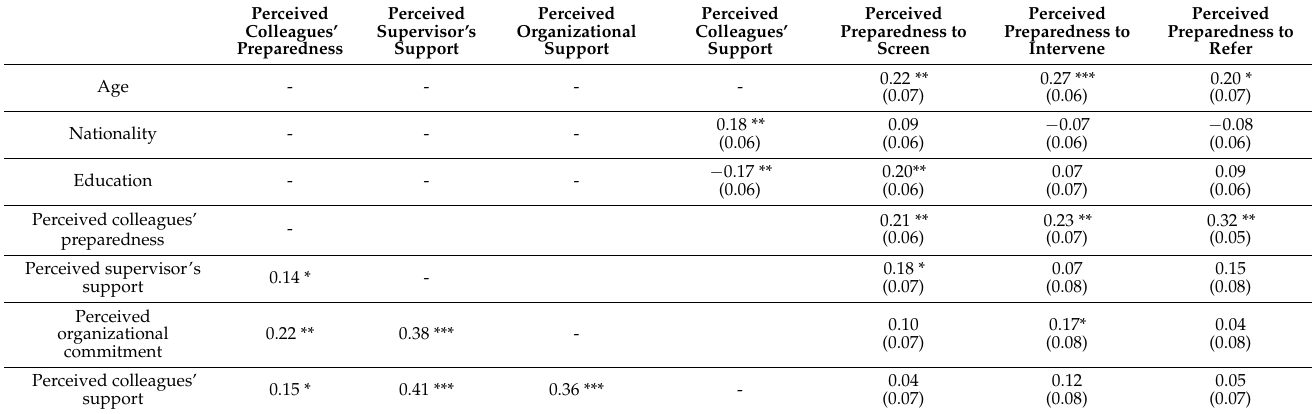
Table 3. Path analysis results, standardized coefficients (N =